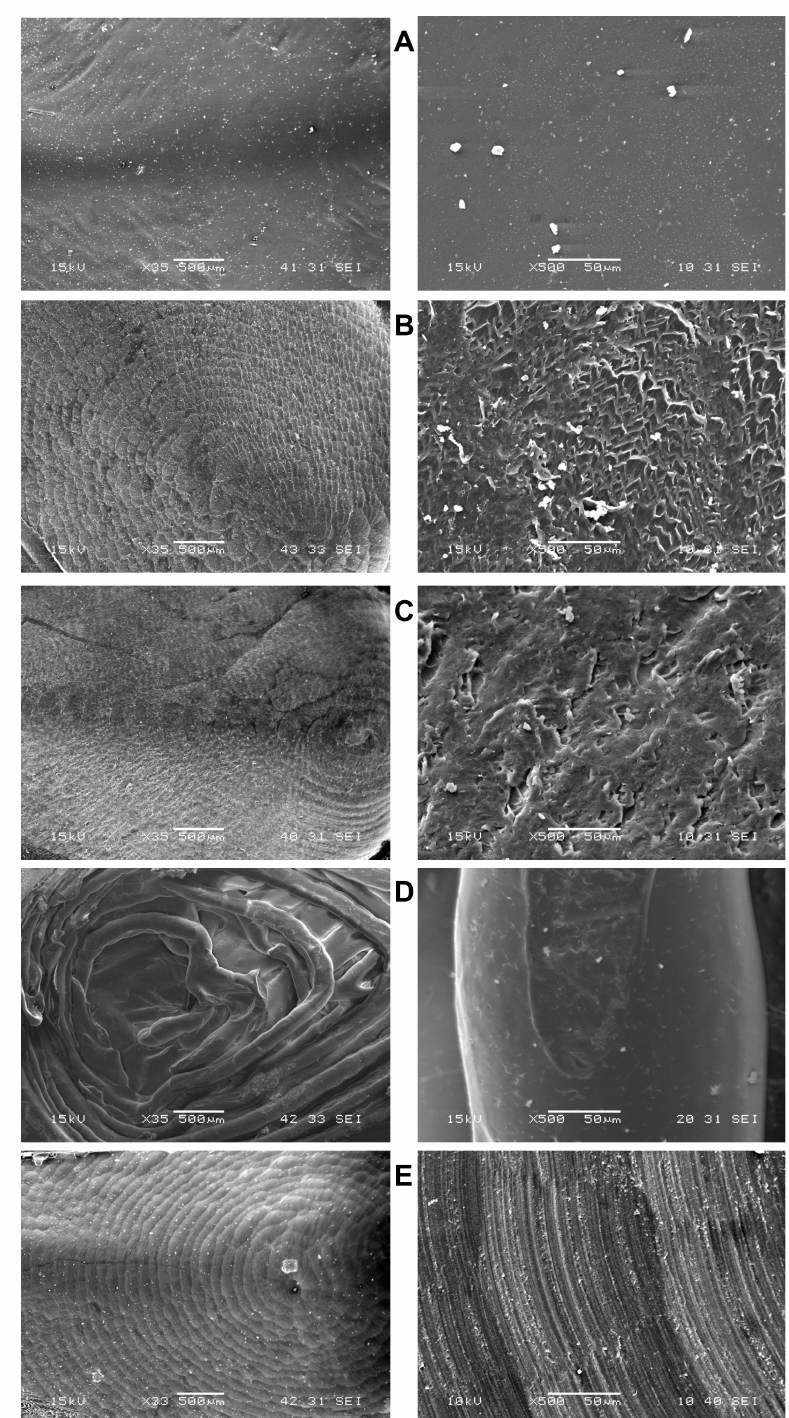
Figure 5. Morphology of the crowns’ inner surfaces. ( A ): Prefabricated polycarbonate crown; ( B ): Milled polycarbonate crown (ZPF); ( C ): Milled polycarbonate crown (TBP); ( D ): 3D-printed polycarbonate crown; ( E ): Milled PMMA crown. The surfaces of prefabricated crowns were smooth. Concentric patterns were observed in the occlusal parts of CNC-manufactured crowns at magnifica- tion 35 × (left column). In milling, these patterns are called scallops and are caused by stepover, i.e., the space between passes of ball nose end mills. At magnification 500 × (right column), plastically deformed zones and small cracks were observed in milled polycarbonates, especially ZPF, and shallow parallel grooves were present on the surfaces of PMMA